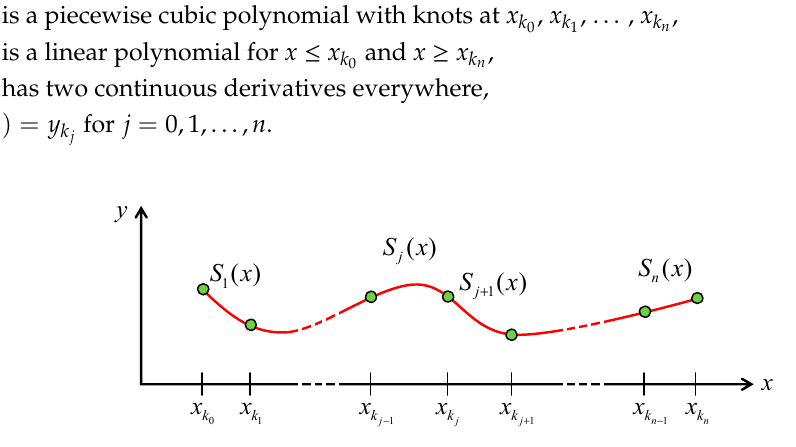
Figure 1. Spline interpolation after Ezhov et al. [2].